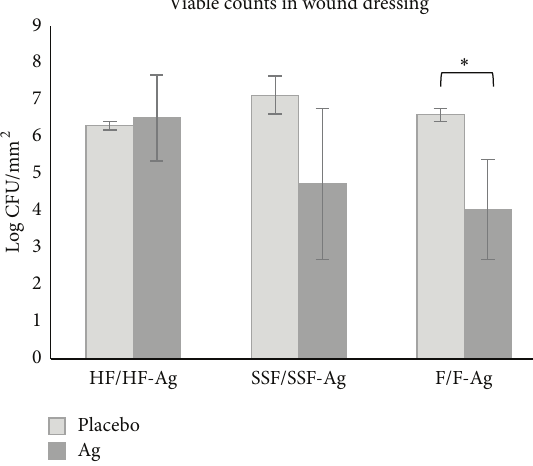
Figure 3: Graph showing bacterial load in wound dressings without (placebo) and with silver (Ag) after 24-hour incubation on inocu- lated SST. Error bars show standard error of the mean (SEM) with 𝑛 = 3 for the placebo samples and 𝑛 = 5 (HF-Ag and F-Ag) or 𝑛 = 6 (SSF-Ag) for the silver containing dressings. ∗ Significantly different from corresponding placebo at 𝑃 < 0.05